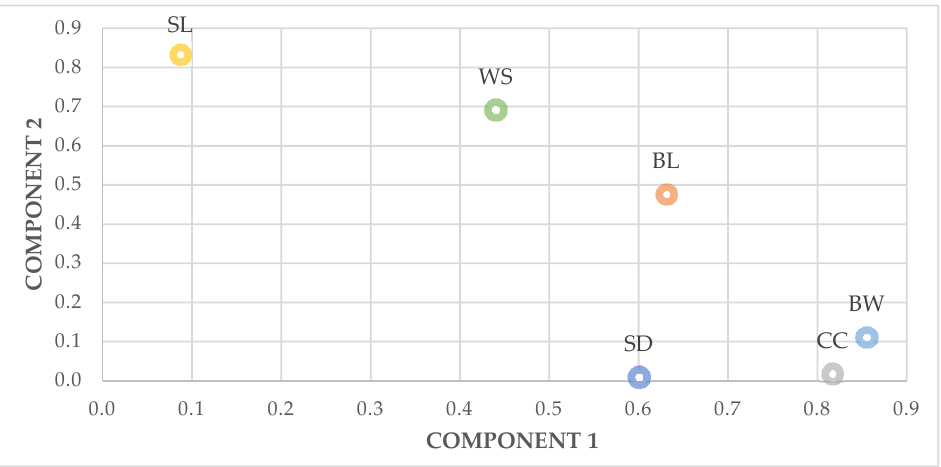
Figure 3. Principal Component Analysis of the zoometric measures in hens. BW: body weight; BL: body length; CC: chest circumference; SL: shank length; SD: shank diameter; WS: wingspan.